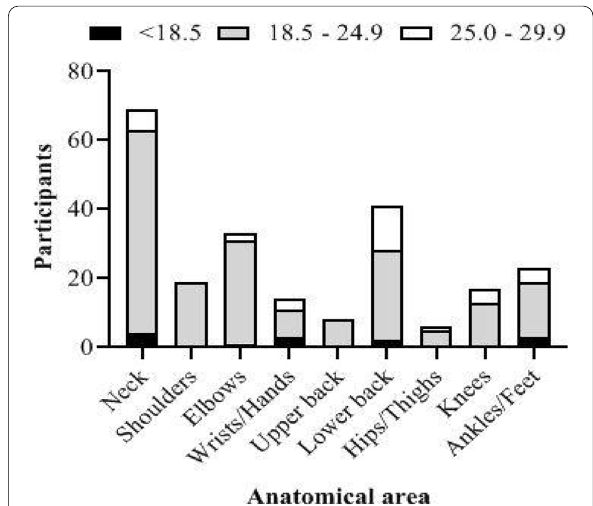
Fig. 2 Illustration of WMSD affected anatomical areas considering